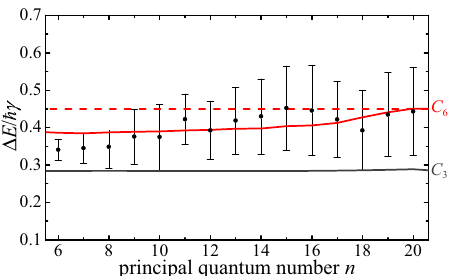
Fig. 3 Universal behavior. The scaled difference Δ E = _ γ ¼ ð Δ 0 (cid:2) Δ max Þ = γ between the maxima and isosbestic points of the transmission signal does not depend on the pump intensity (see Fig. 1f, g) and is shown here as a function of the principal quantum number n of the probe excitons. For homogeneously broadened laser excitation, it becomes a universal quantity that only depends on the type of the interaction and is given by Δ E / ℏ γ = 0.45 for van der Waals interactions, V ( r ) = C 6 , as indicated by 6 / r the dashed red line. Phonon coupling leads to asymmetric line broadening and causes slight deviations from this behavior (red solid line) in excellent agreement with the measurements shown by the black dots. Other potentials, such as direct dipole-dipole interactions, V ( r ) = C 3 / r 3 , do not match the observations (gray line). The error bars denote the standard